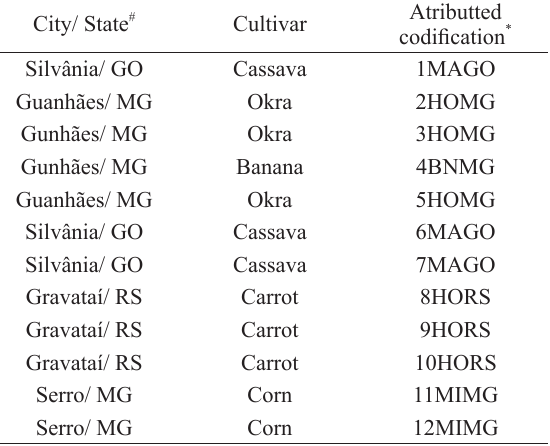
enzimatic index using the cut off of 1.5.